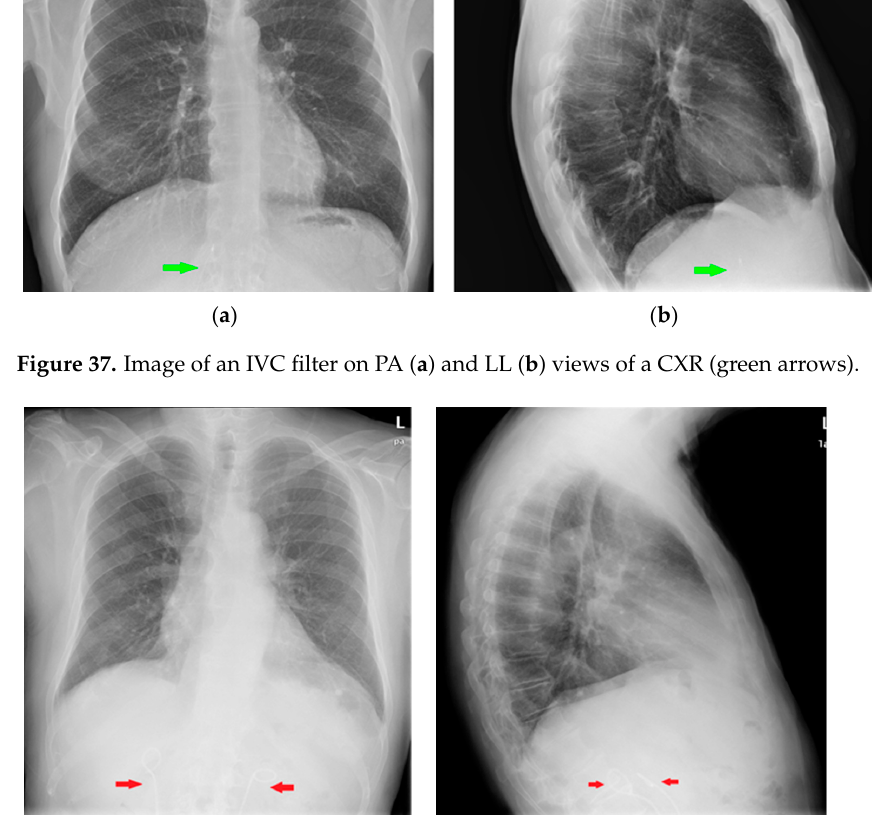
Figure 36. PA ( a ) and LL ( b ) CXR of a patient with sternal wires resulting from a transverse ster-